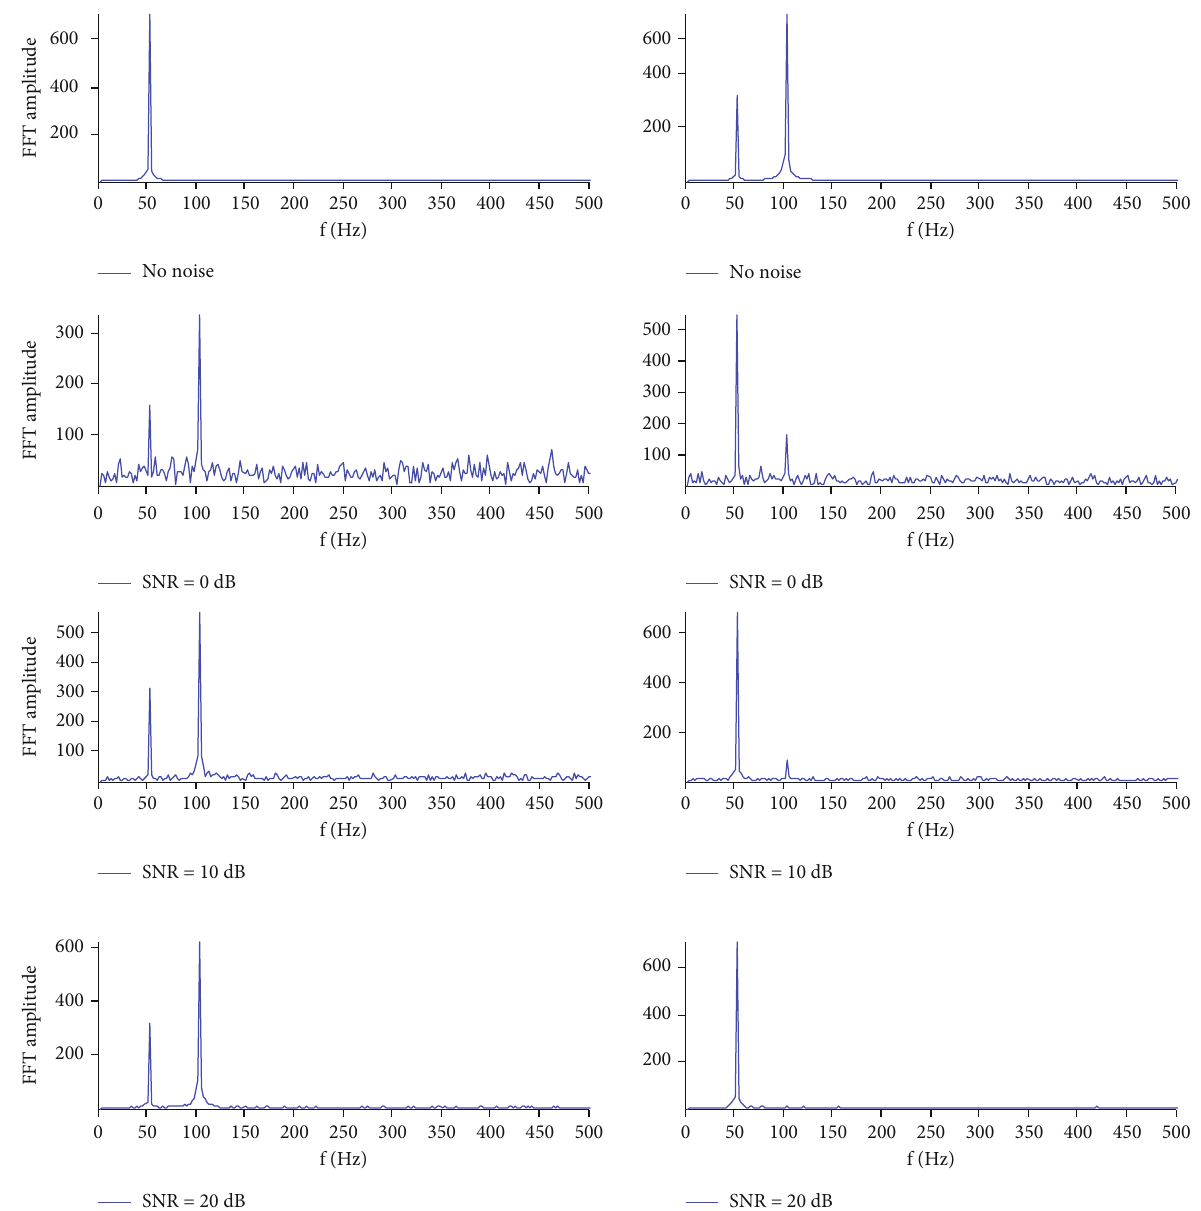
(b) The separated frequency domain signals with di ff erent noises by FastICA Figure 4: Time-frequency waveforms of the FastICA